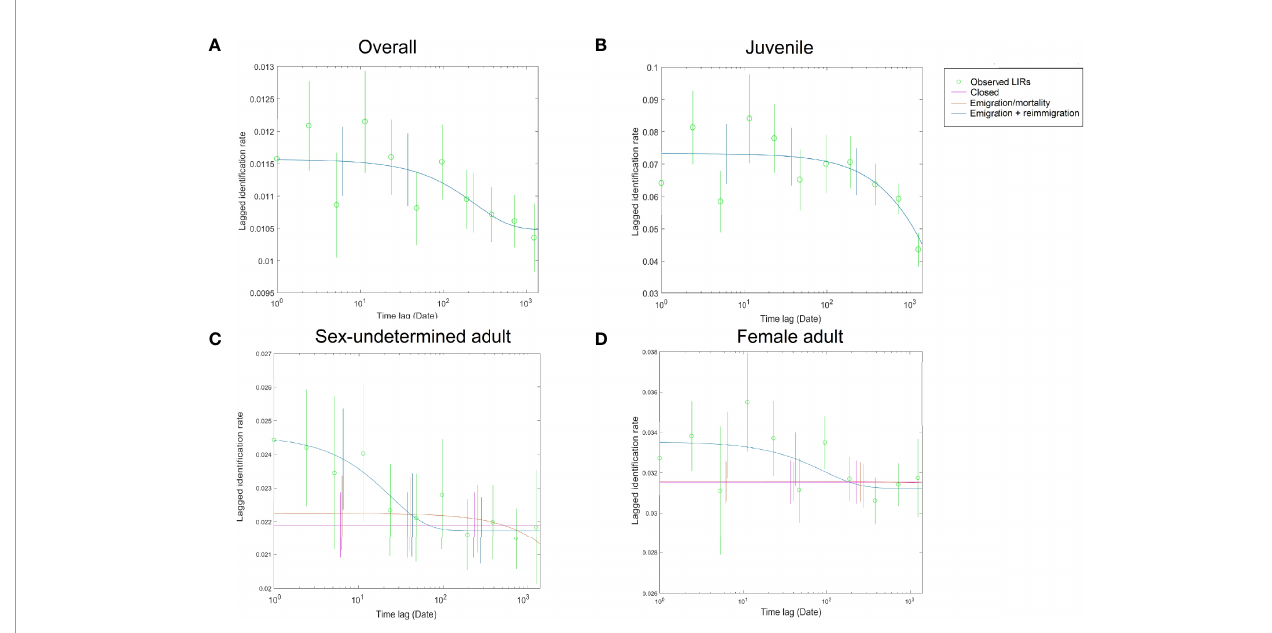
FIGURE 5 | Lagged identi fi cation rate (LIR) and the best- fi tted hypothetical models for (A) the overall DRE Indo-Paci fi c humpback dolphins; (B) the juveniles; (C) the sex-undetermined adults; and (D) the female adults. The less favored models with D QAIC ≤ 2 (see details in Supplementary Data S1 ) are also shown for the sex- undetermined and female